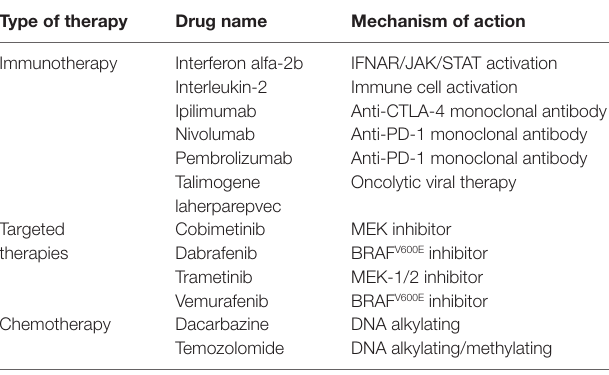
TAbLe 1 | Current FDA-approved therapies for